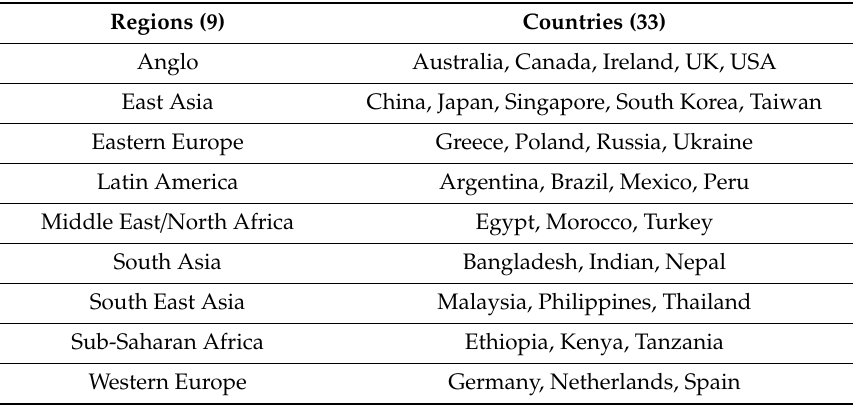
Table 6. Geographical coverage of the 2012 Survey of World Views